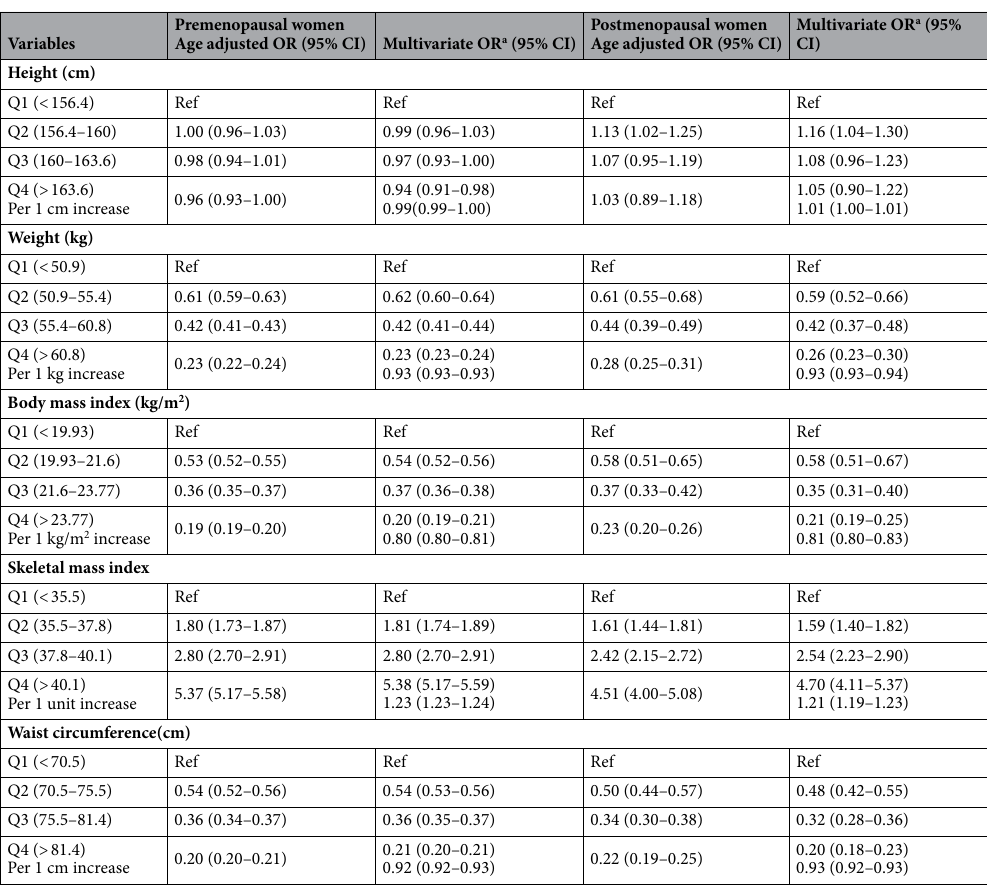
Table 3. Associations between higher mammographic density and anthropometric factors by menopausal status. a Odds ratios (ORs) and 95% confidence interval (95% CI) from the multivariate model including age and all variables (age at menarche, parous, History of estrogen replacement therapy, calcium level adjusted to albumin) presented in the Table